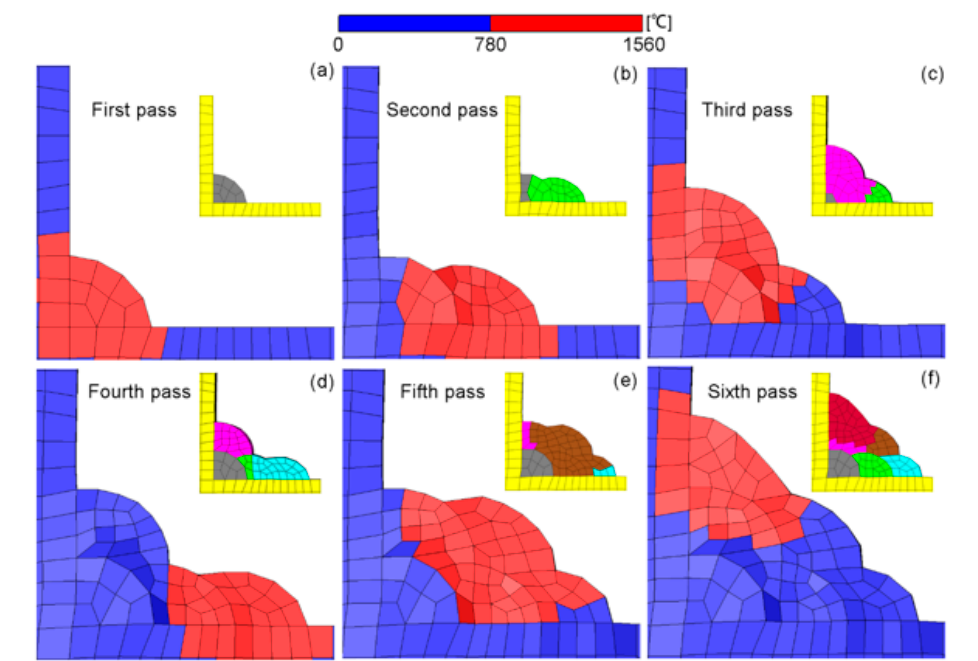
Figure 7. Temperature distribution during the welding process for the redefinition of the CTE of LTT bead: ( a ) first pass; ( b ) second pass; ( c ) third pass; ( d ) fourth pass; ( e ) fifth pass; ( f ) sixth pass.